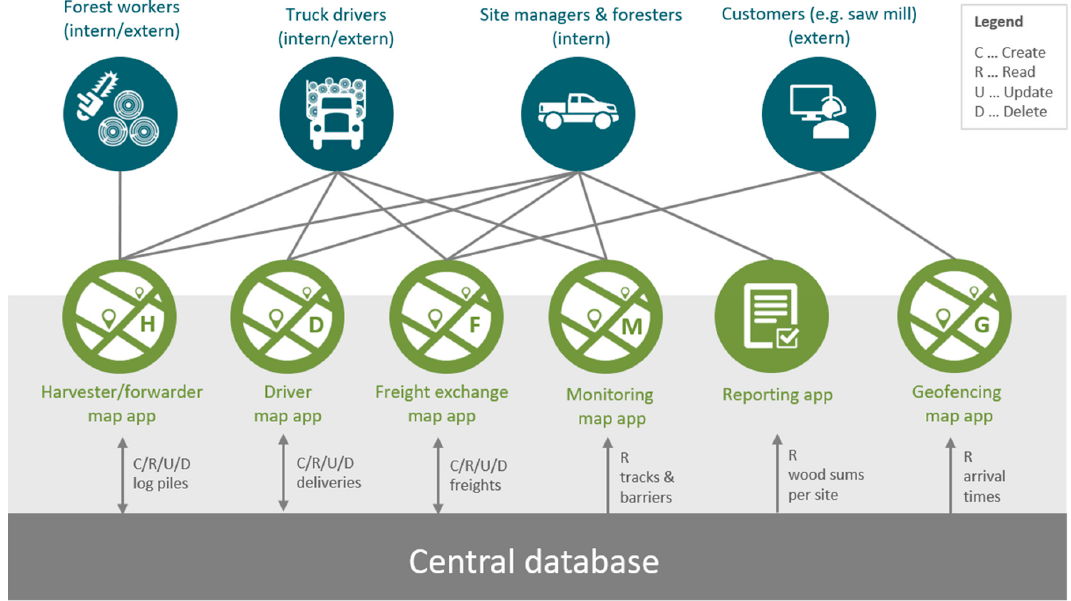
Figure 5. Identified major roles, their tasks and the corresponding web mapping apps.